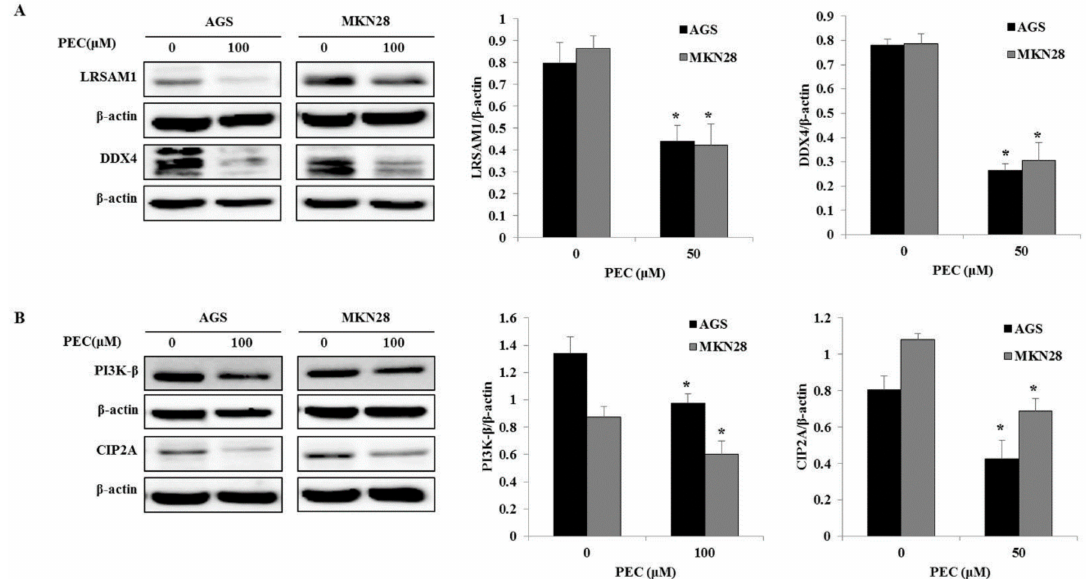
Figure 7. Validation of differentially expressed proteins using immunoblotting. ( A , B ) The cell lysates prepared from Control (DMSO)—and PEC (100 µ M)-treated cells were subjected to SDS-PAGE for protein separation and LRSAM1, DDX4, PI3K- β , and CIP2A proteins were detected using the corresponding antibodies, and β -actin was used as a loading control. The experiments were performed in triplicate (* p < 0.05 vs.